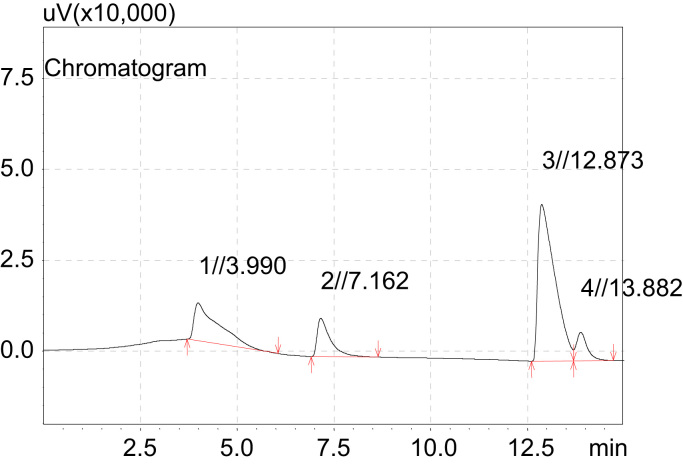
Sample standard.